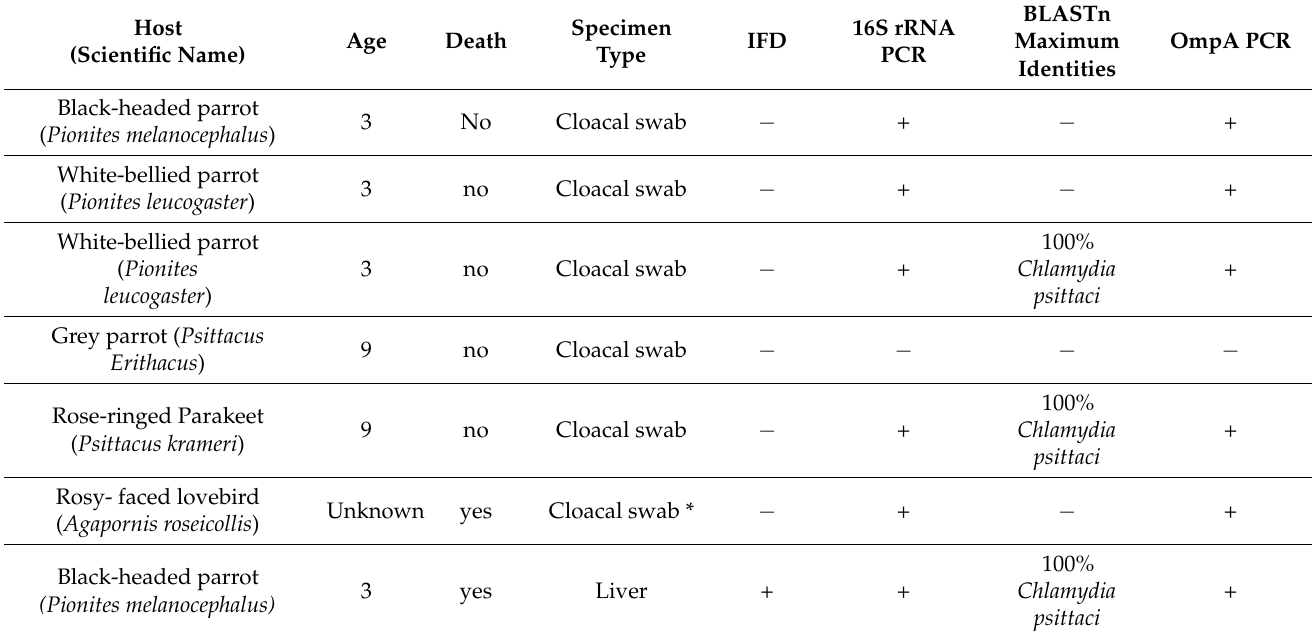
Table 1. Origin of samples investigated in this study, and summary of IFD, PCR (16S rRNA and ompA genes) and BLASTn maximum identities of the 16S rRNA gene sequences.